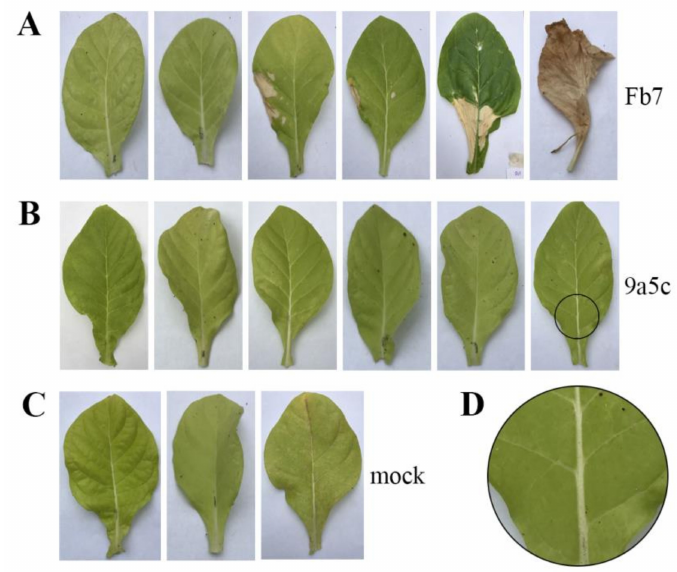
Figure 7. Nicotiana tabacum leaves, after 30 days of inoculation with Xylella fastidiosa strain Fb7 ( A ), Xylella fastidiosa strain 9a5c ( B ), and the negative control ( C ) inoculated with the PW medium (mock). These are representative of the most severe symptoms observed. ( D ) Close-up showing veinal